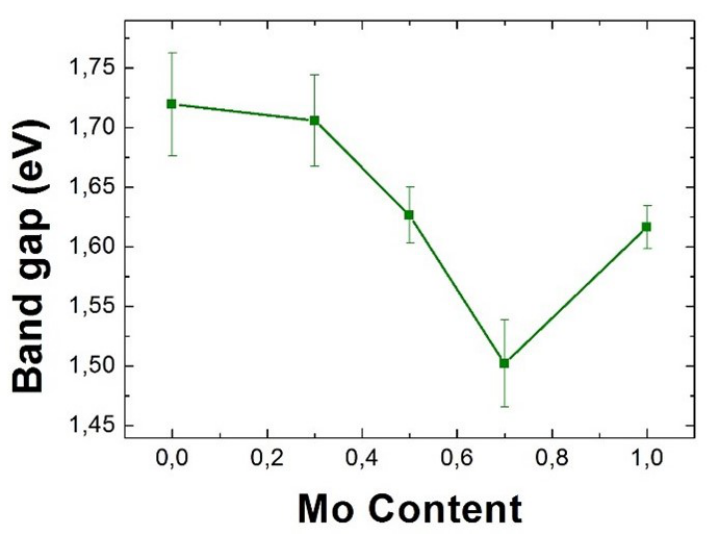
Figure 4. Band gap as a function of the Mo content for Richardson-Lucy deconvoluted EELS spectrum-line. The error bars represent the statistical deviation among